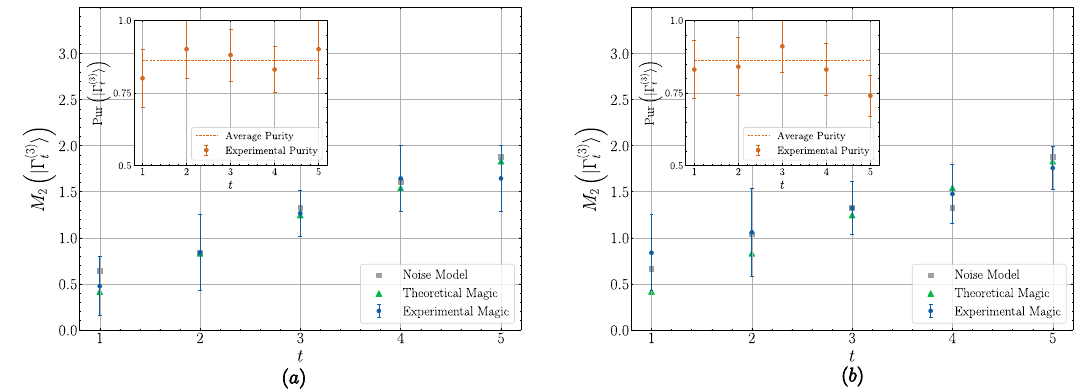
Fig. 4 Stabilizer 2-Rényi entropy for n = 3. Plot of the stabilizer 2-Rényi entropy for a ibmq_quito and b ibmq_casablanca. Both fi gures contain the experimental values (blue dots), the theoretical values (green triangles) of the magic for the desired pure state, and the noise model values (gray squares) of the magic for the mixed state prepared on the quantum processor. The values of the magic of the Γ ð 3 Þ t for t = 1, … , 5 are plotted as functions of the number of T -gates t in the doped random Clifford circuits (see Supplementary Tables III and IV in the Supplementary Note 4 for the data). See Fig. 3 for the preparation of such states. Both fi gures contain in the upper left corner the purity (orange dots) of the output state prepared on the quantum processor and its average value (dashed line). Here the number of resources N TOT ≡ N U × N M depends on the number of T -gates t thrown in the circuits as N TOT ¼ 2 A 3 þ B 3 ð 5 (cid:2) t Þ , where A 3 = 10.6 ± 0.3, B 3 = 0.56 ± 0.08, see Supplementary Table I in Supplementary Note 4 and Fig. 7 in “ Methods. ” Note that the experimentally observed magic can be — and typically is — higher than the theoretically predicted magic. This is because imperfectly performed Clifford gates are no longer exactly Clifford and can inject uncontrolled/unwanted magic into the system. This effect is enhanced for more qubits and deeper circuits.